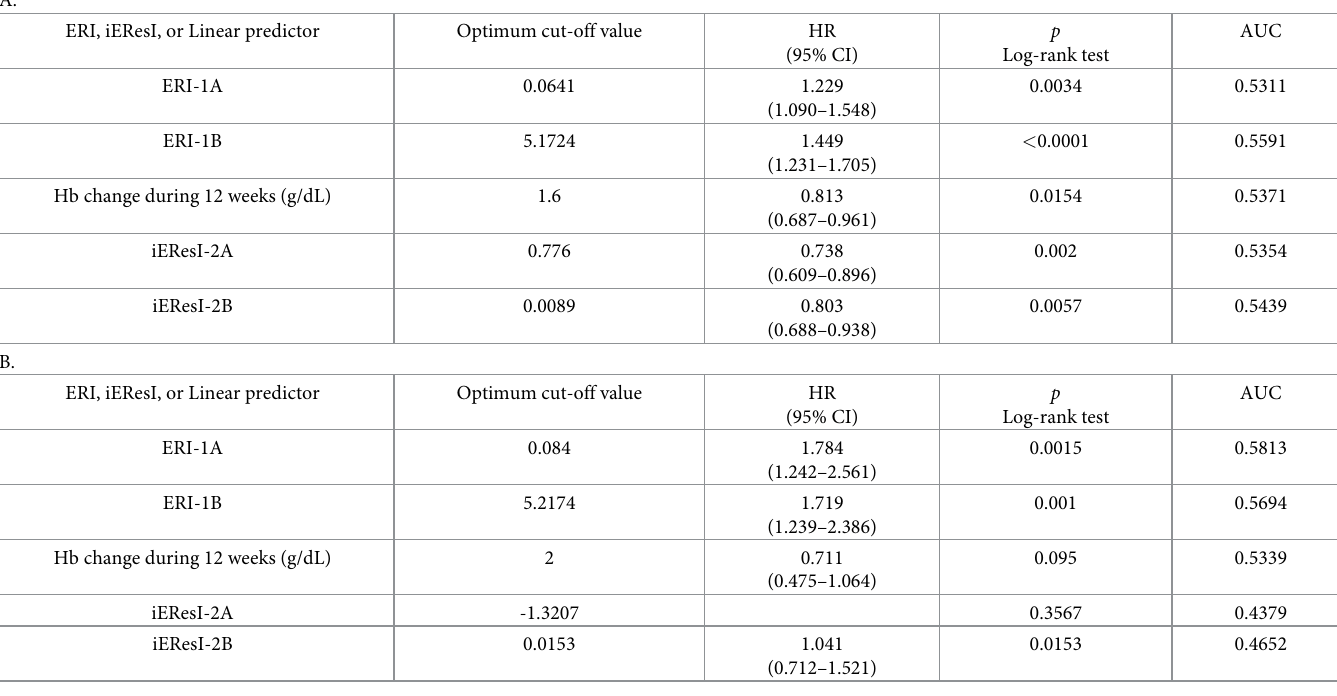
adjusted DA doses, or those with change in the Hb level were not consistently significant for the association, and the cut-off values for both outcomes tended to be discrepant. We initially assumed that formulae using weight-adjusted DA dose was more correctly associated with the responsiveness to ESA than those with absolute ESA dose; however, this was incorrect. Although this study could not clearly provide the reason for this unexpected finding, this sim- ple equation could estimate correctly, for example, apparent high responsiveness by weight loss due to undernutrition. Accumulating evidence has indicated the negative prognostic value of a poor initial response to ESAs [29–33]. In the TREAT study, the definition of poor responsiveness to ESA in patients with ND-CKD was operationally defined as < 2% in the first month after weight- based doses of DA, which was the lowest quartile of change in hemoglobin level. This result Table 4. A. Optimum cut-off values for deterioration of renal function. B. Optimum cut-off values for cardiovascular disease